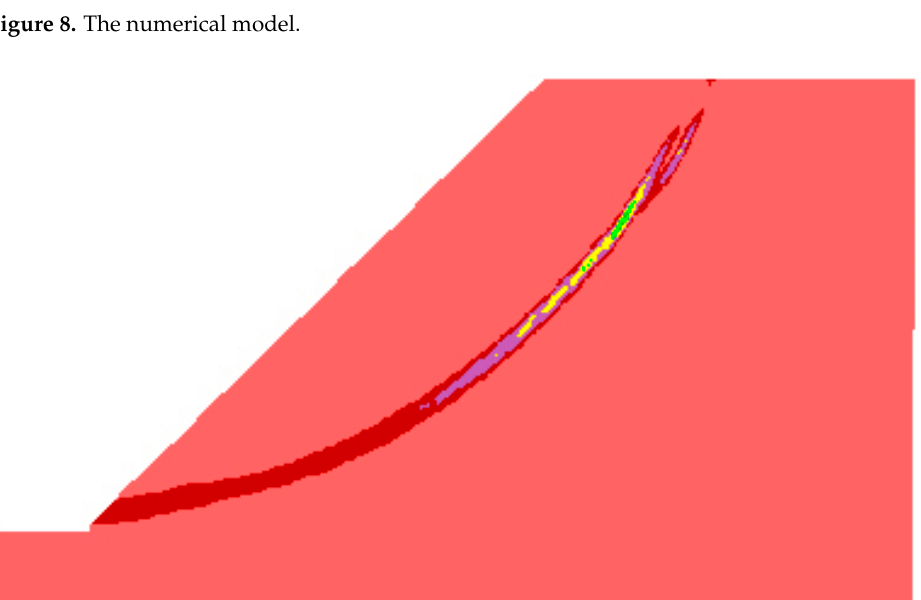
Figure 9. Stability analysis and failure mode by numerical solution at the mean point (FOS = 1.13).